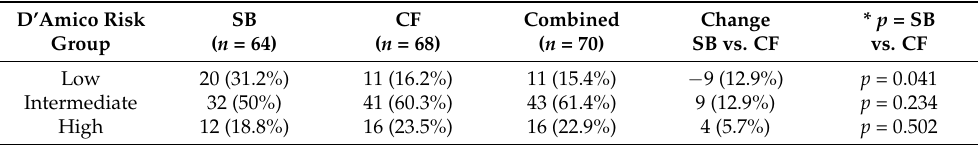
Table 2. Distribution of D’Amico risk groups for patients diagnosed with prostate cancer in our study (number, percentage % of the specific group). CF = cognitive fusion biopsy, SB = systematic biopsy, Combined = combination between SB and CF methods. * chi-square test.